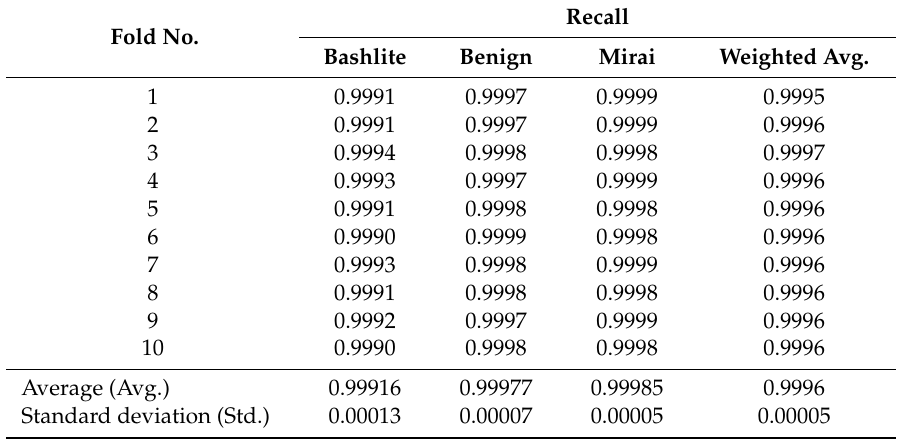
Table 9. Recall results of the 10-fold cross-validation for Mirai, Bashlite, and benign classifications using the selected feature